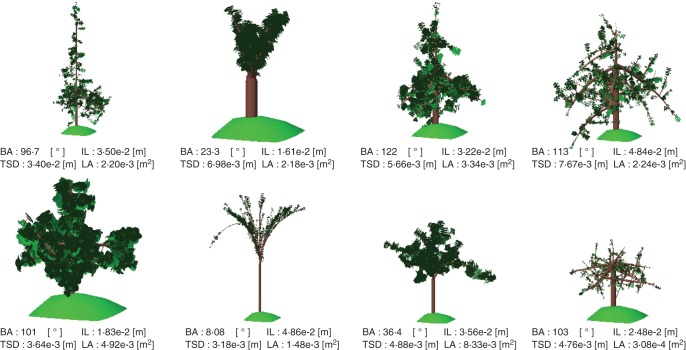
Visualization of simulated architectures for apple trees (Malus × domestica). These sample architectures were produced by MAppleT with different values of geometrical investigated parameters. The green area below the simulated tree has a constant size and thus its purpose is to act as a visual aid in terms of relative tree size.